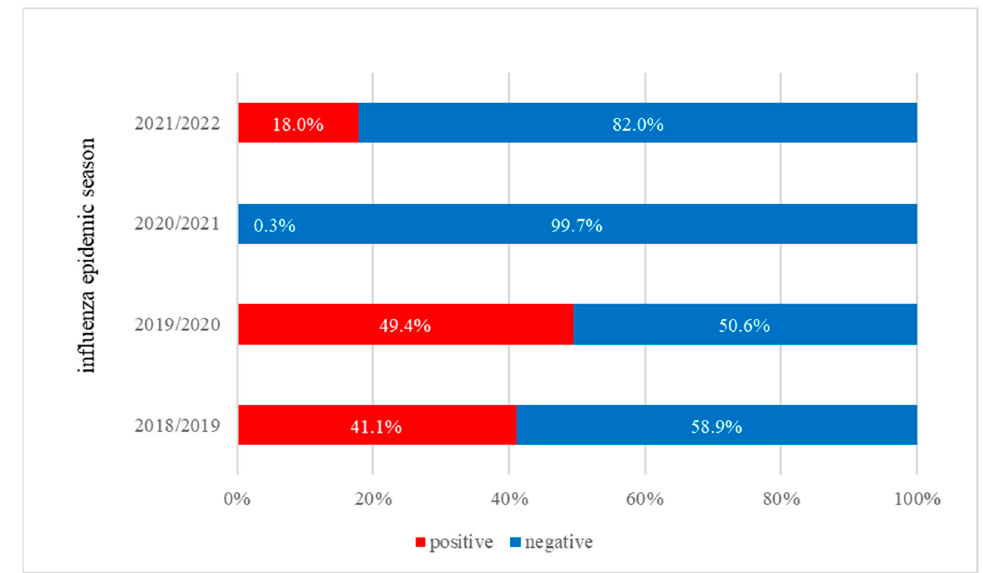
Figure 2. Percentage of positive and negative samples in the last four epidemic seasons.